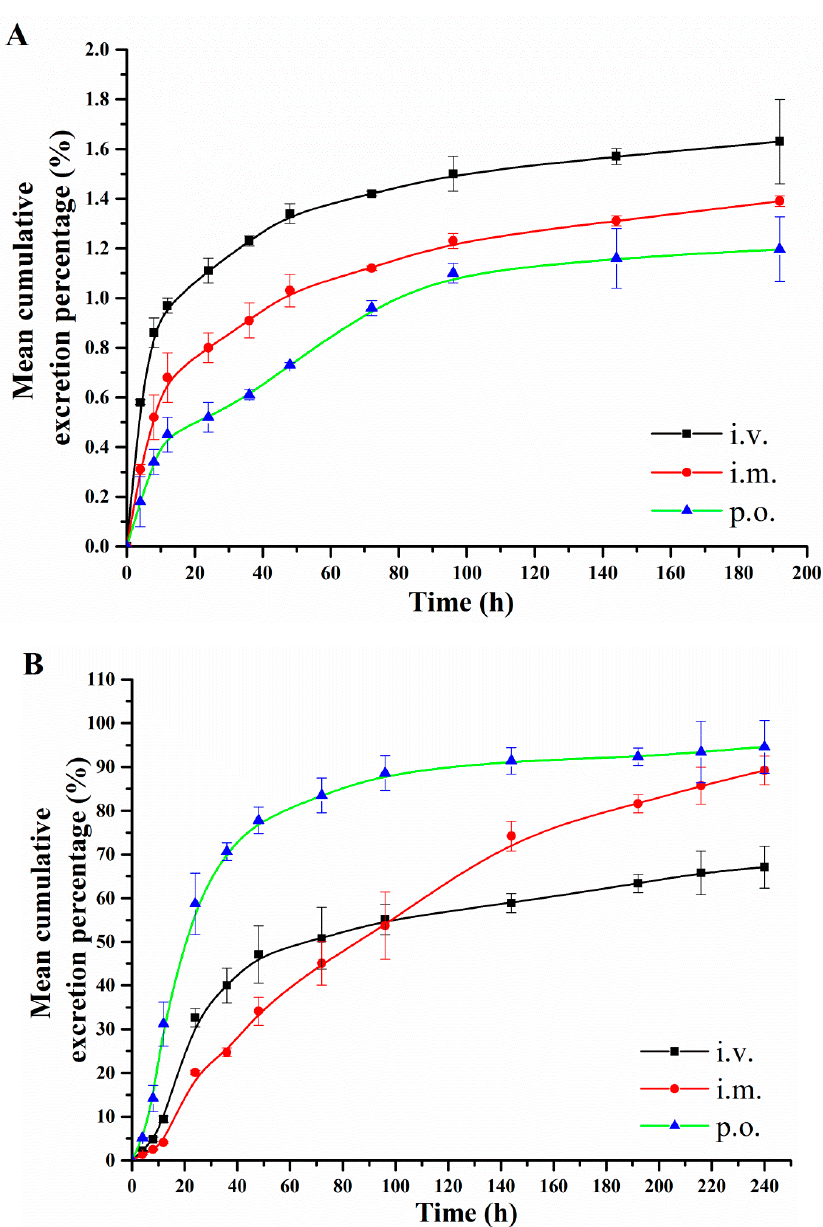
Figure 5. Mean cumulative excretion percentage-time profiles of DPTM in rat urine ( A ) and feces ( B ) following i.v., i.m. and p.o. administration at a dose of 75 mg/kg ( n = 6).